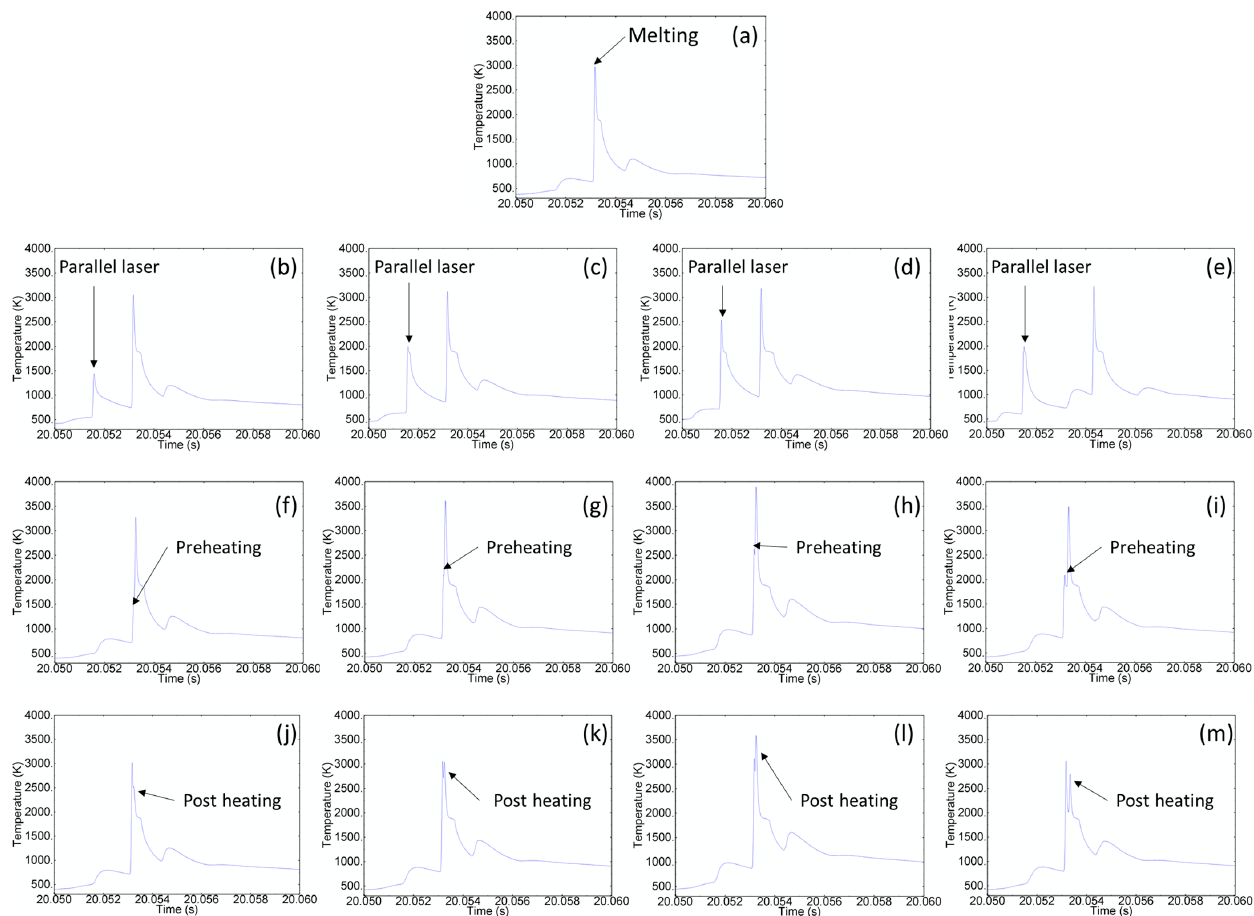
Figure 7. Temperature history for different scanning modes and process parameters: ( a ) single laser beam; ( b – e ) parallel model; ( f – i ) preheating mode; ( j – m ) post ‐ heating mode.